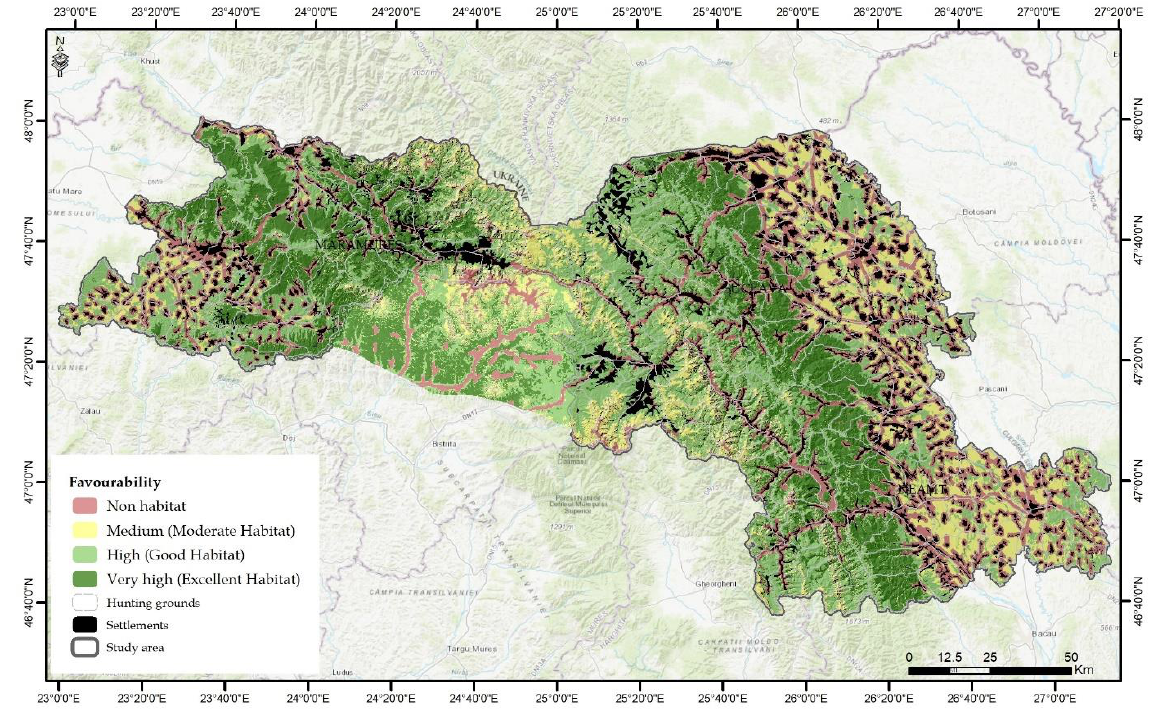
, and Maramures counties for the , ,